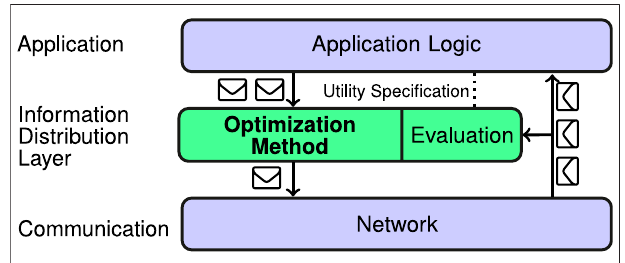
FIGURE1| Designoftheproposedinformationdistributionmiddleware. Application logic generates messages that are then intercepted by the introduced information distribution layer. The optimization method decides which ones are worth forwarding to the communication layer (i.e., sending). In order to do so, it utilizes the evaluation model, which can be adjusted for the mission at hand using utility speci fi